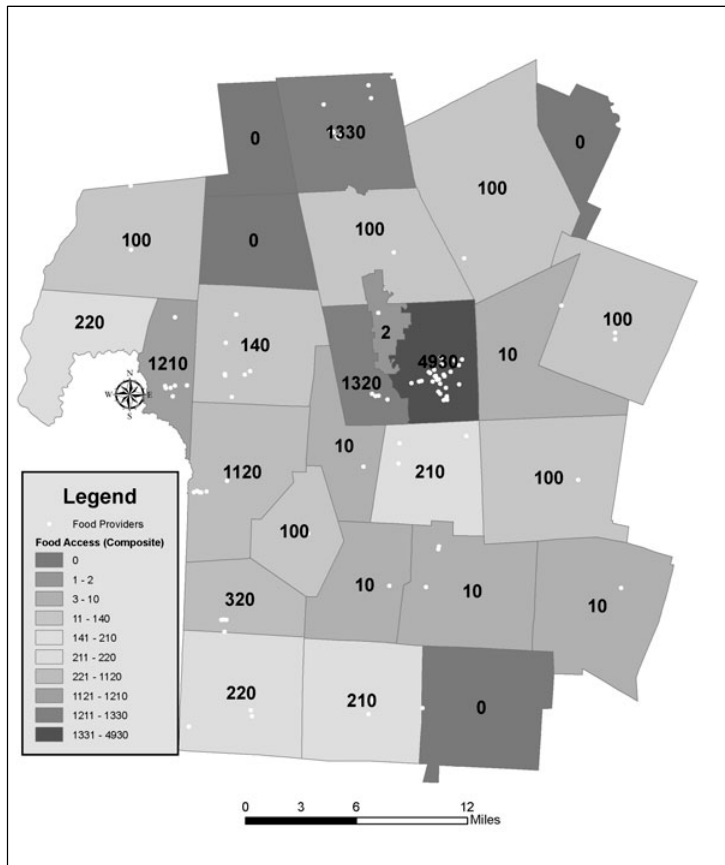
Figure 7. Composite Index of Food Access in Rutland County Created by Ranking Food Providers by Type and Adding the Total Number of Providers in Each